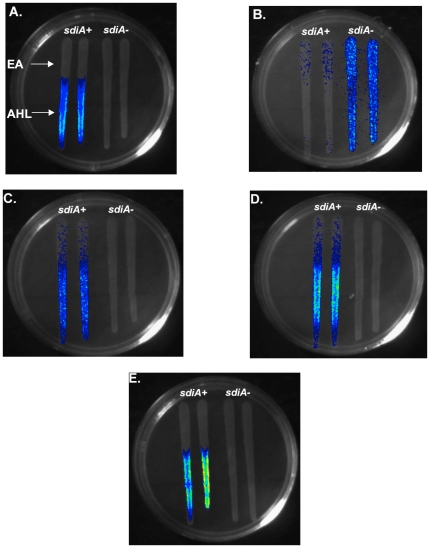
Cross streak assays of the E. coli K-12 and EHEC lux fusions.The chromosomal lux fusions and their respective sdiA mutants were grown in broth overnight. The strains were dripped down the plate perpendicular to 20 µl of EA then 20 µl of 10 µM oxoC6 (diagrammed in Panel A for all panels). Plates were incubated at 37°C for 7 hours then light emission was imaged using a C2400-32 intensified charge-coupled device camera with an Argus 20 image processor. A) AL4001/JLD800 (gadW), B) JLD604/JLD803 (fliE), C) JLD605/JLD804 (gadE), D) JLD607/JLD806 (yhiD), E) JLD610 /JLD809 (hdeA).